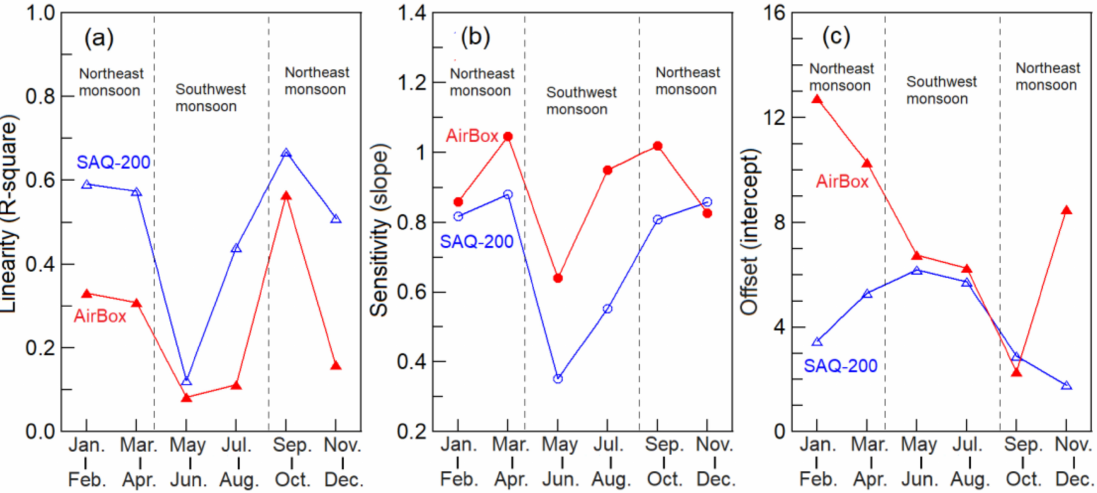
Figure 6. The variations of ( a ) linearly, ( b ) sensitivity, ( c ) and offset of the two low-cost PM 2.5 sensor systems during periods 1 − 6 of